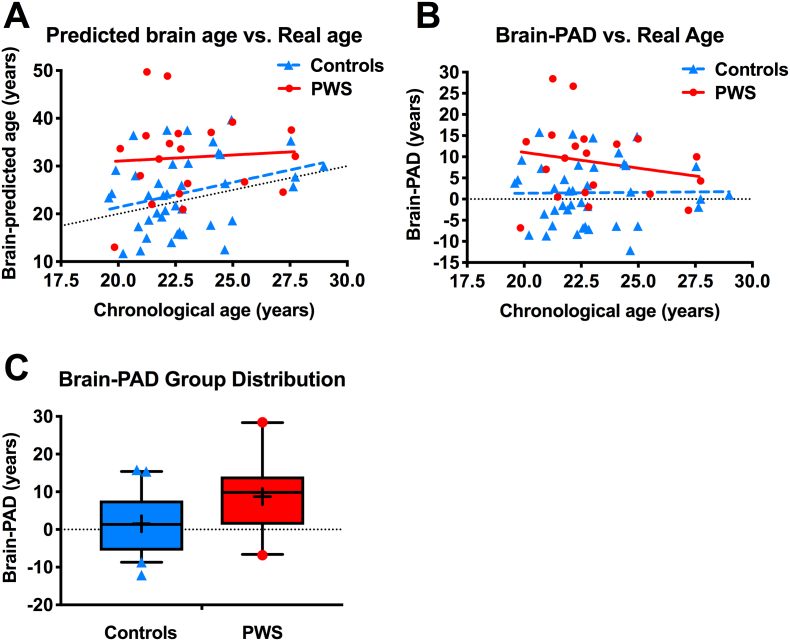
Brain-predicted age in individuals with Prader-Willi syndrome (PWS) and controls (cohort 1).(A,B) Scatterplot of (A) brain-predicted age or (B) brain-predicted age difference (brain-PAD) (y-axis) vs. chronological real age (x-axis) in controls (blue triangles, blue dashed linear regression line) and individuals with PWS (red circles, red solid linear regression line), with line of identity (black dotted line). (C) Boxplot shows brain-PAD scores distribution with median, interquartile range, and bars showing 5th and 95th percentiles, with outliers as symbols, and mean as a cross. (For interpretation of the references to color in this figure legend, the reader is referred to the web version of this article.)